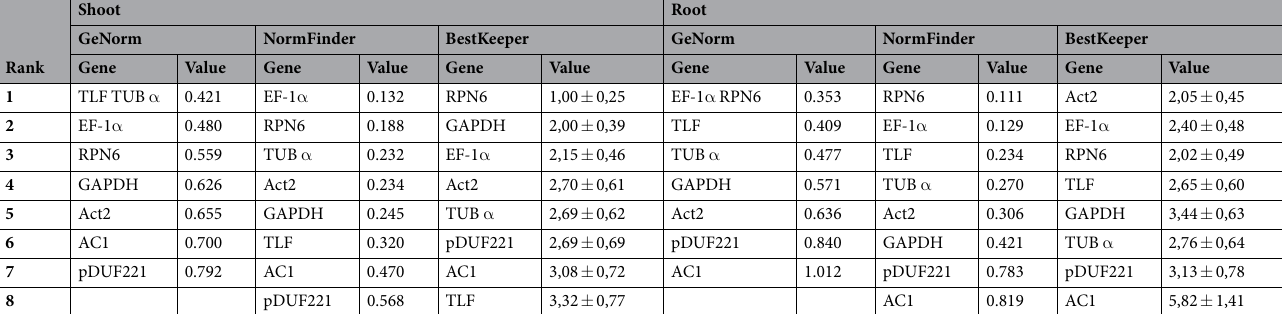
Table 2. Stability ranking of each candidate reference gene using different algorithms in shoot and root.